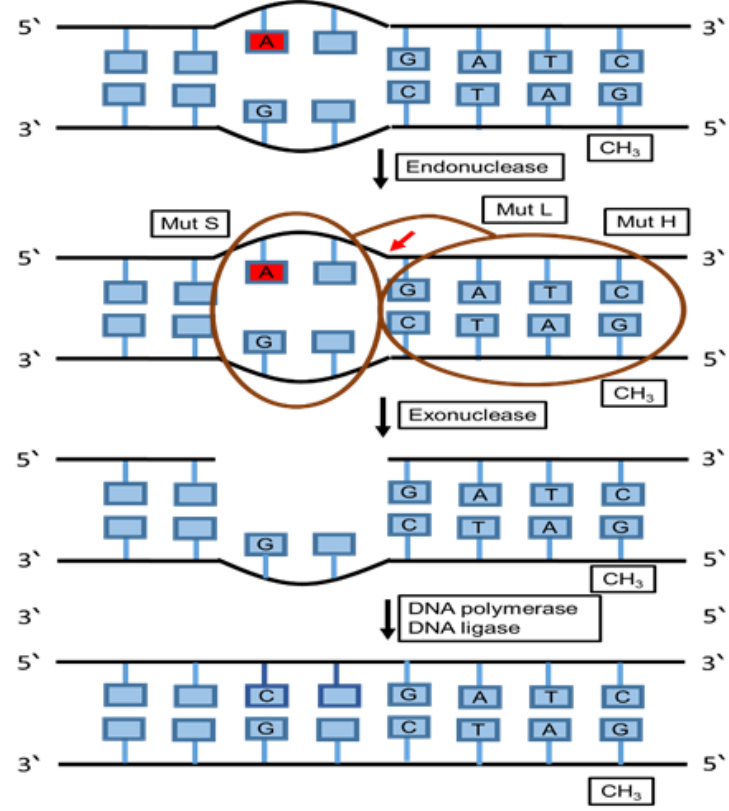
Figure 5. Mismatch repair (MMR) pathway. The schematic diagram summarizes the main components and the mechanism of the mismatch repair pathway. This repairing pathway removes and replaces mispaired bases that were not fixed during proofreading using a group of proteins that recognizes and binds to the mispaired base. Then, other protein complexes chop off the DNA near the mismatch, which is followed by cutting of the incorrect nucleotide and surrounding patches of DNA using specific enzymes in order to be able to replace the missing section with the correct